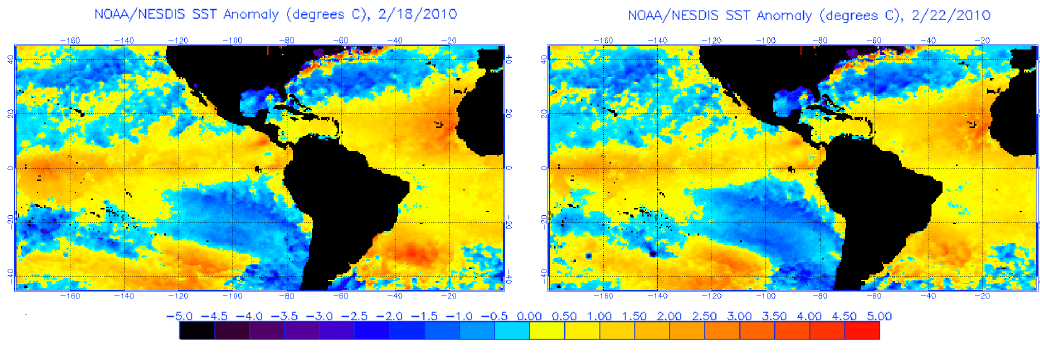
Fig. 13. SST anomalies for 18 th and 22 nd of February 2010.